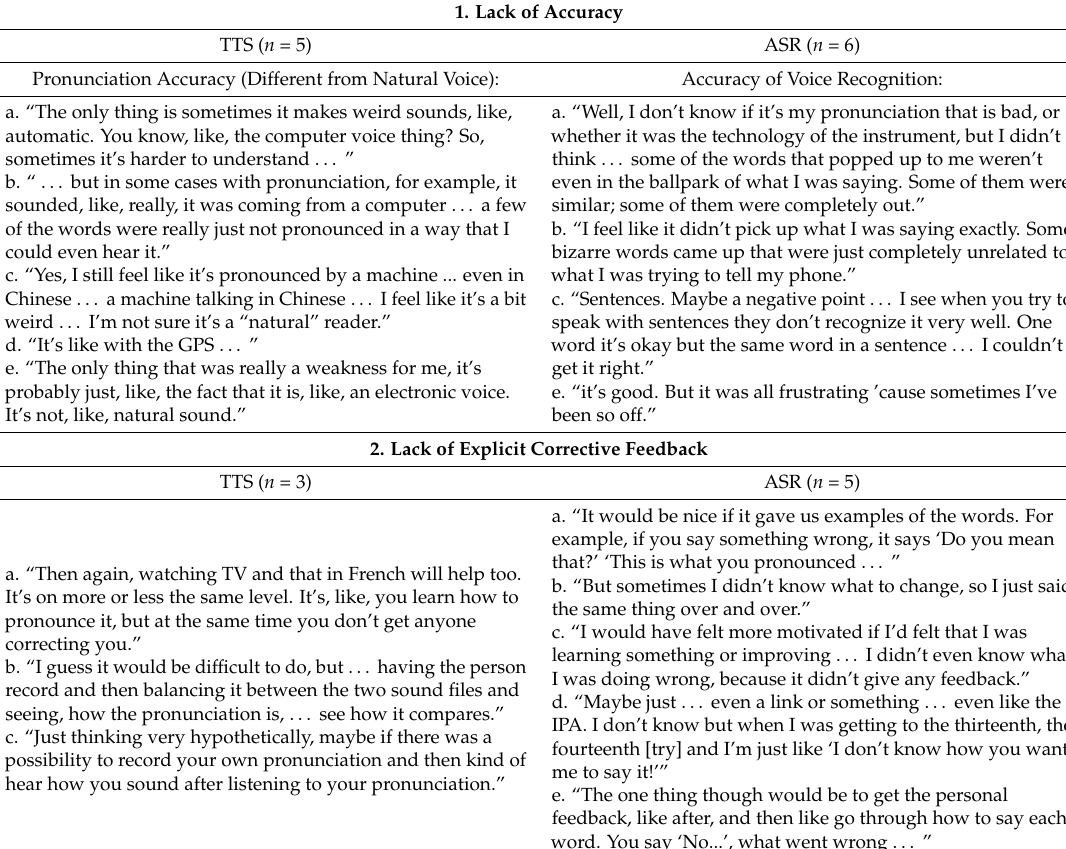
Table 3. Perceived weaknesses of TTS and